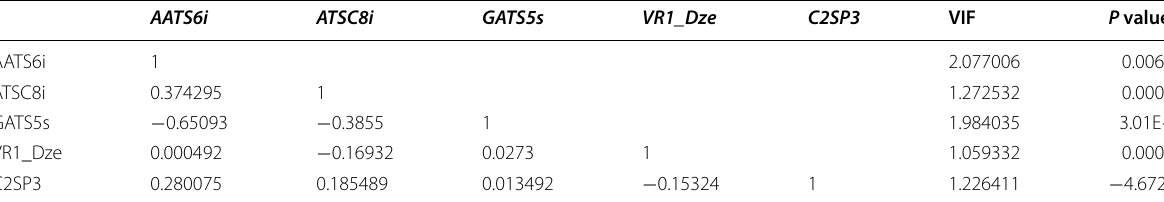
Table 11 Statistical analysis of the descriptor used in the QSAR